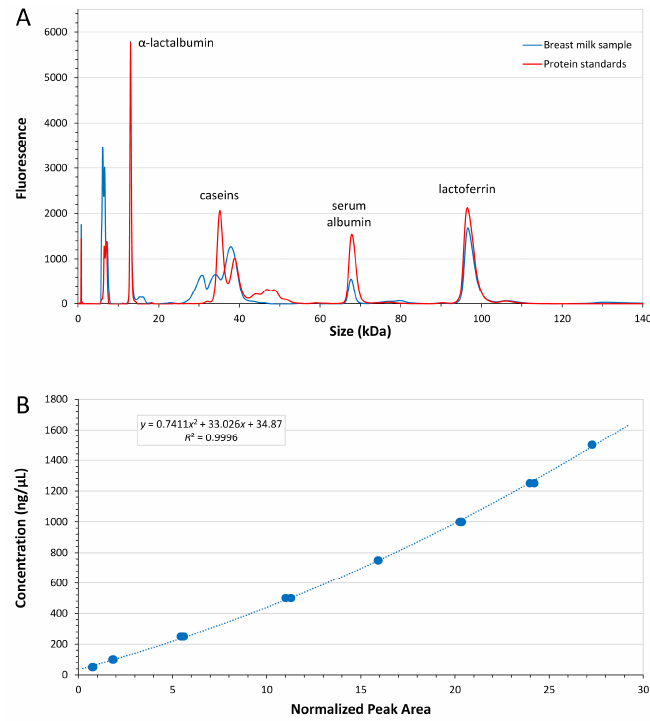
Figure 2. ( A ) Human breast milk protein separation on the LabChip GX II system. The electropherogram overlay depicts individual standard milk proteins (red) and a typical human breast milk sample trace (blue); ( B ) Calibration curve for α‐ lactalbumin (in duplicates, 50–1500 ng/ μ L, R 2